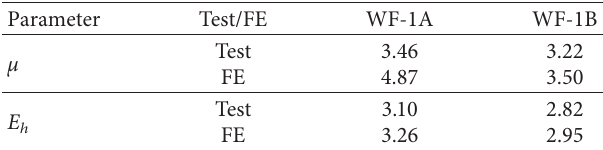
Table 2: Ductility coefficient μ and energy dissipation coefficient E h . Parameter